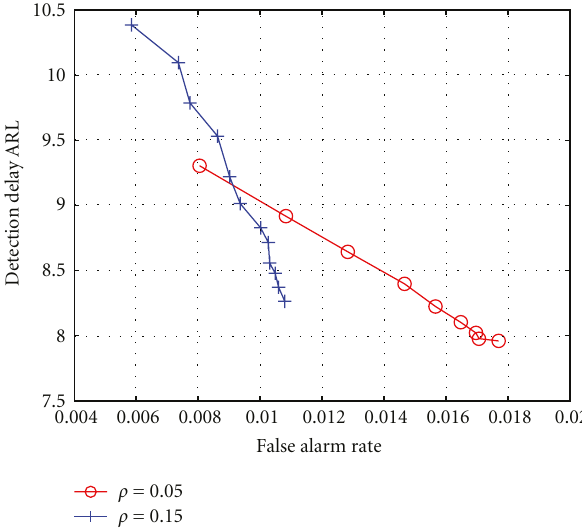
Figure 9: Tradeo ff between false alarm rate and detection delay ARL when approximate DP is